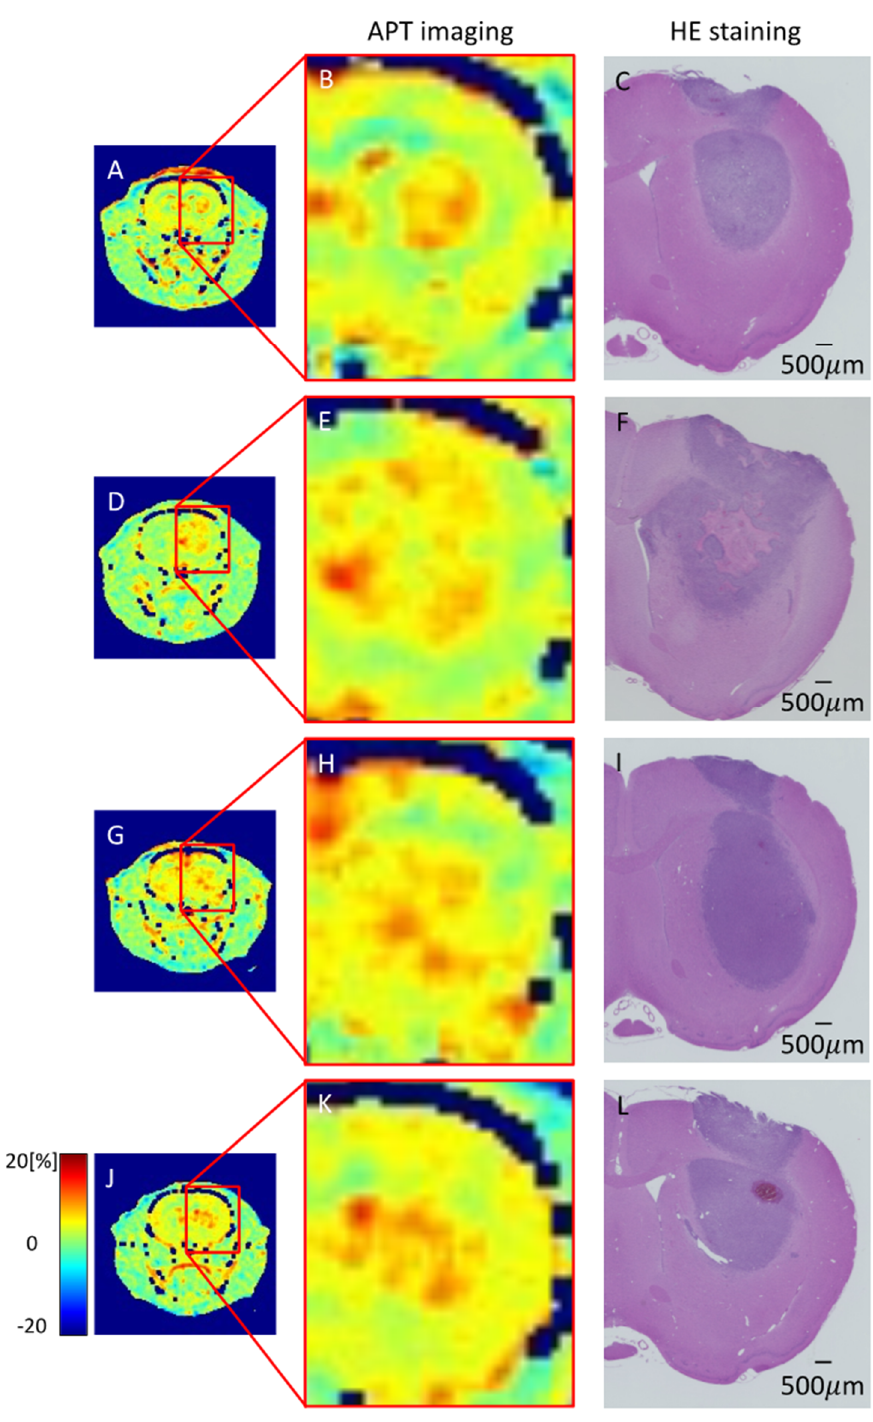
Figure 8. APT imaging and HE staining in pre-treatment group ( A , B , C ) on day 7 after transplanta- tation and non-treatment ( D – F ), TMZ-40 mg ( G – I ), and TMZ-60 mg ( J – L ) groups on day 14 after tion and non-treatment ( D , E , F ), TMZ-40 mg ( G , H , I ), and TMZ-60 mg ( J , K , L ) groups on day 14 after transplantation.